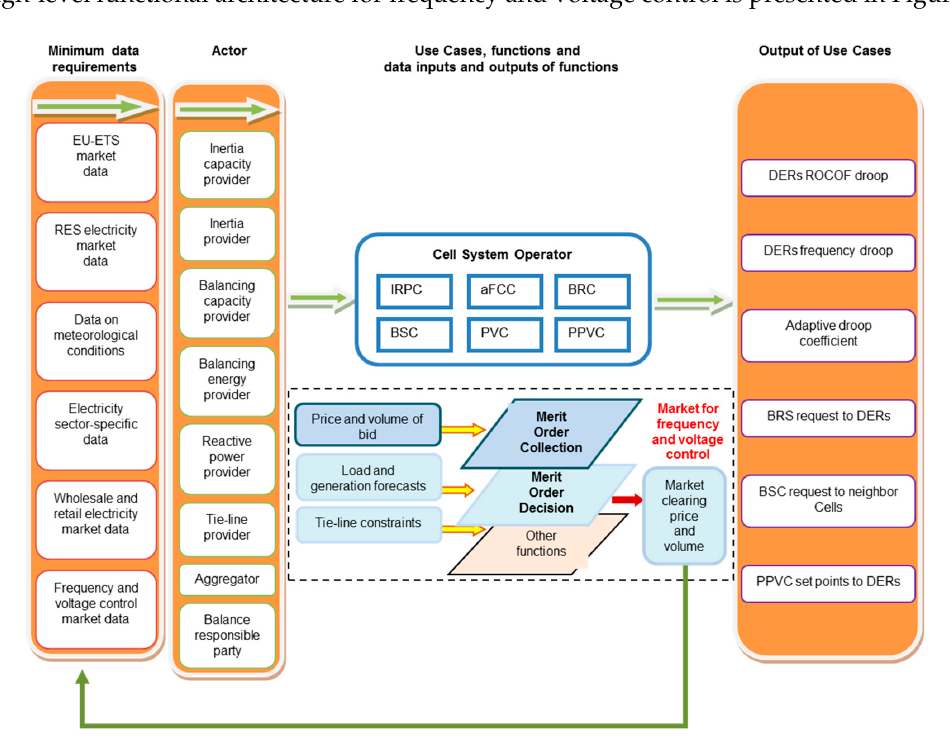
Figure 3 . High-level architecture for frequency and voltage control under the Web-of-Cells (WoC) concept [35].